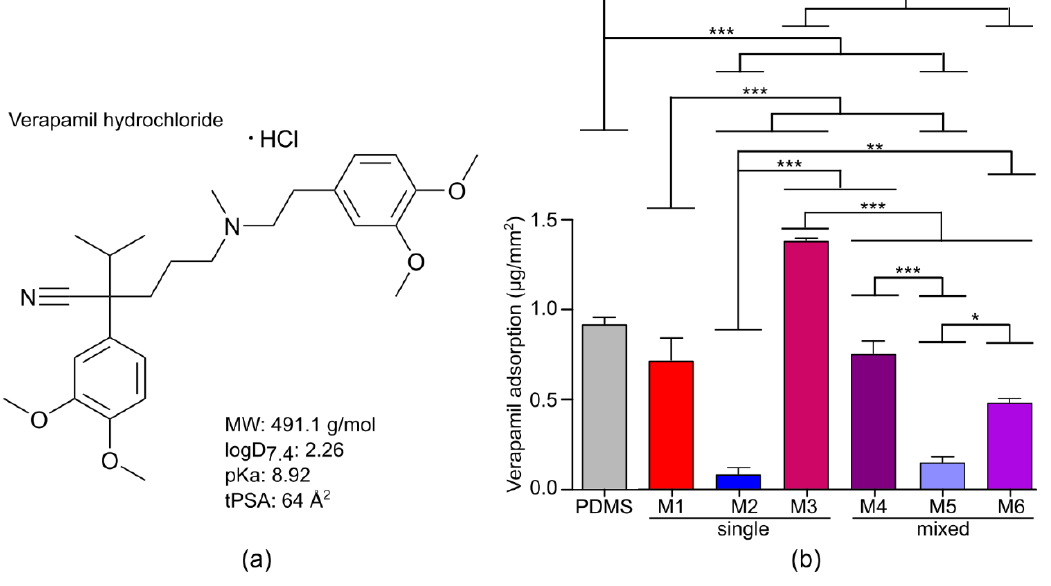
Figure 3. Verapamil adsorption to the membranes. ( a ) Chemical structure of verapamil hydrochloride and important physicochemical properties for drug development and adsorption studies. ( b ) Verapamil adsorption to the uncoated membranes and PDMS as control after 3 h. Data are the results of three experiments and depicted as mean ± SEM.